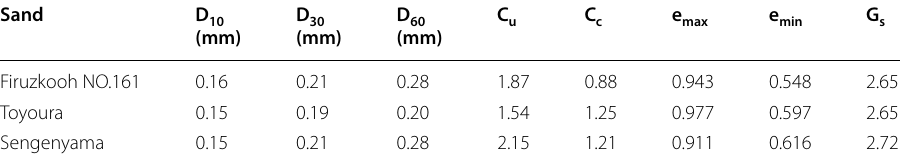
Table 1 Characteristics of Firoozkooh 161 sand compared with Toyoura and Sengenyama sand